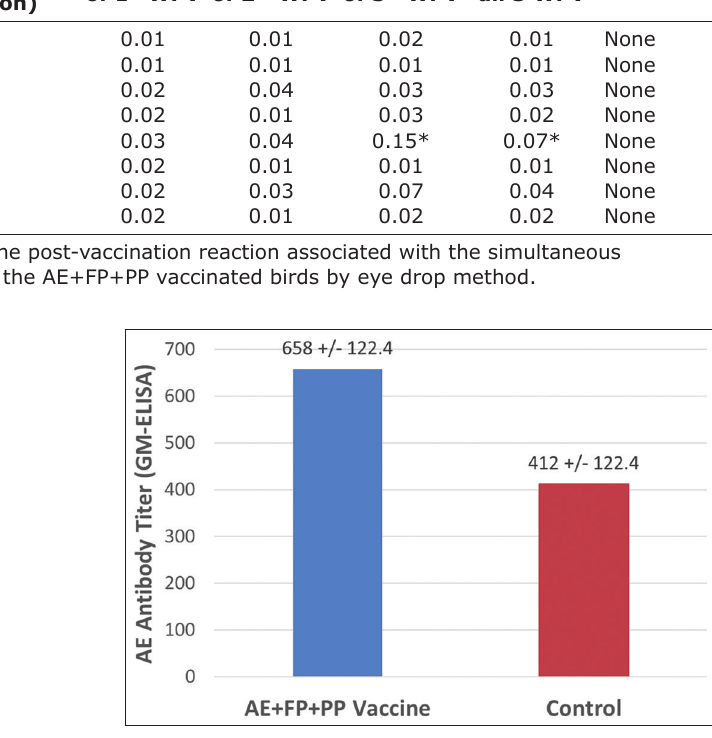
Figure-2: Avian encephalomyelitis (AE) antibody titer in the AE + fowlpox + pigeon pox vaccinated chickens compared to the control flocks. Number of serum samples tested =